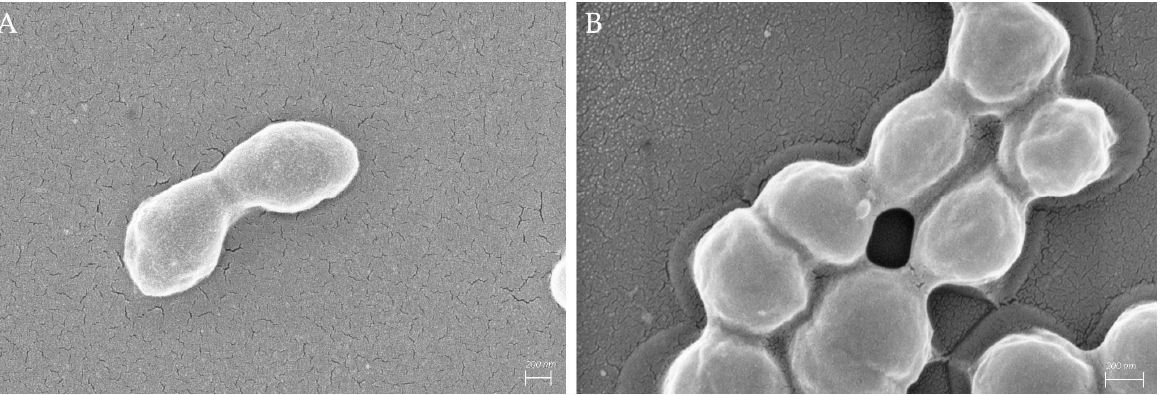
Figure 5. SEM images of native S. epidermidis ( A ); and S. epidermidis incubated with 50 mg/L. MIP nanoparticles overnight ( B ) .